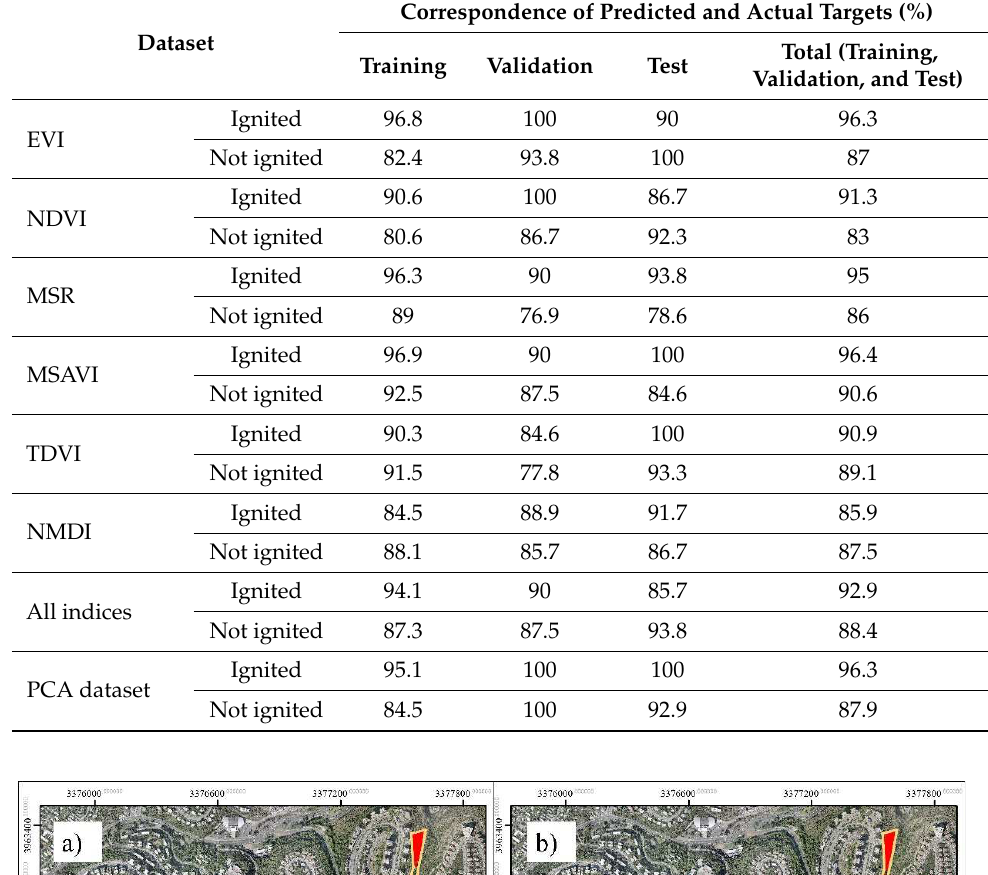
Table 2. The results of the Confusion Matrix of trained PRNN.